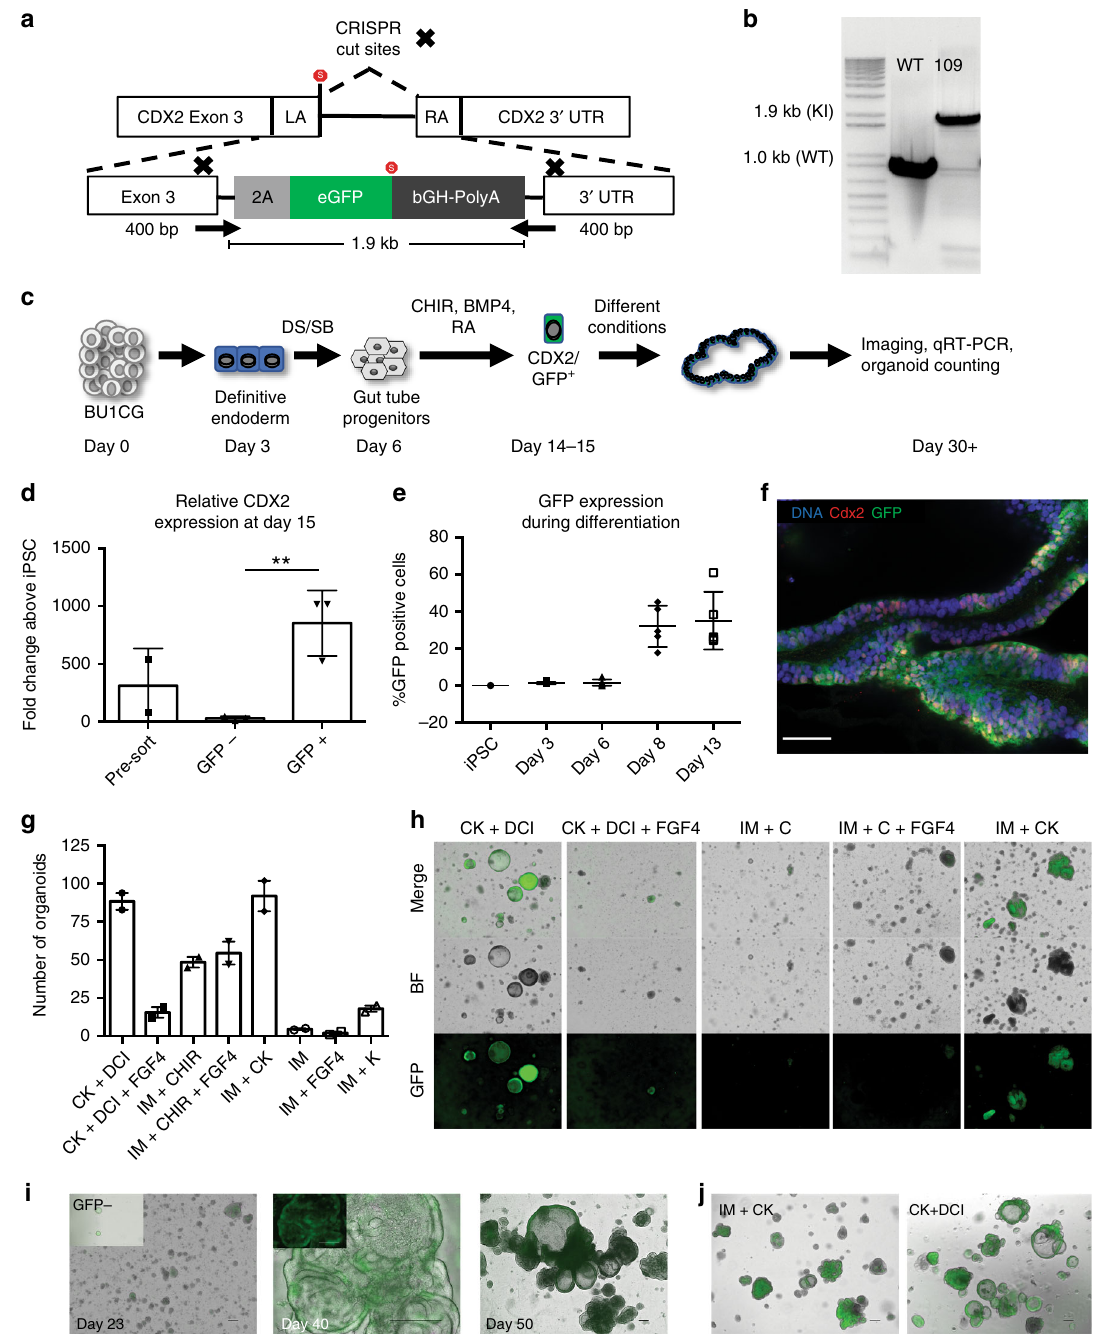
Fig. 4 A CDX2-GFP iPSC reporter line for intestinal differentiation. a Detailed schematic of the reporter construct and PCR screening primer sites (arrows). b Positive PCR screening of mono-allelic (17) and bi-allelic (109) knock-in clones derived from iPSC line bBU1c2. c Experimental schematic of differentiation of BU1CG into HIOs. d qRT-PCR for CDX2 expression in cells at day 15 of differentiation comparing sorted GFP + to both GFP − sorted cells as well as pre-sort (2 − ΔΔ CT technical triplicates normalized to GAPDH , n = 3 independent sorts, error bars represent the s.d., p = 0.007, ** p < 0.01) as determined by unpaired Student ’ s t -test). e FACS analysis of GFP expression during the fi rst two weeks of differentiation ( n = 4 independent differentiations, error bars represent the s.d.). f Quanti fi cation of number of organoids per independent well obtained at day 50 of differentiation (error bars indicate s.e.m. from n = 2 independent wells per condition). g Whole mount immuno fl uorescence of HIOs at D40 of differentiation stained for Cdx2, GFP, and DNA (blue) (scale bar = 50 μ m, representative of n = 6 organoids from n = 2 differentiations). h Representative micrographs of HIOs at day 34 of differentiation using different media conditions (originally sorted at day 14 for CDX2 GFP , scale bar = 100 μ m, representative fi elds of view of n = 2 wells per condition). i Representative micrographs showing the formation of HIOs from BU1CG after sorting GFP + cells at day 14 (scale bar = 200 μ m). Inset shows limited outgrowth from GFP − sorted cells cultured in the same media conditions (IM + CK) (scale bar = 200 μ m) (representative of n = 3 differentiations). j Representative micrographs showing HIOs at day 45 comparing CK + DCI vs IM + CK conditions (scale bar = 200 μ m, representative of n = 6